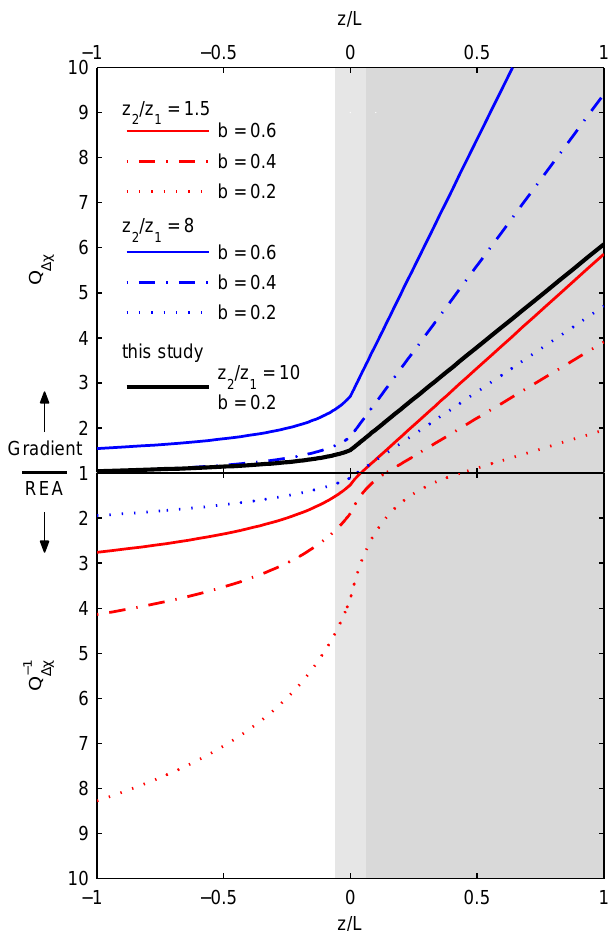
Figure 11. Expected 1χ( Gradient) /1χ (REA) ratio ( Q 1 χ) dis- played on the upper y axis and the 1χ( REA) /1χ (Gradient) ra- ) displayed on the lower y axis (reversed) versus z tio, ( Q − 1 . 1χ L = 8 (blue Shown are the ratios determined with Eq. (11) for m = z 2 z 1 = 1.5 (red lines), representing gradient measure- lines) and m = z 2 z 1 ments above low and high vegetation, respectively, and b values of 0.6 (solid line), 0.4 (dashed line) and 0.2 (dotted line). The black line was calculated with the settings from this study ( m = (z 2 − d)/(z 1 − d) = 10 and b = 0.21). The upper measurement height of the gradient measurement ( z 2 ) was used as a reference height for z in Eq. (11) and in the calculation of the integral turbulence char- L acteristics (Eq. 12). The shaded areas indicate ranges of unstable (white), neutral (light grey) and stable (dark grey) conditions. Dur- ing the latter, fluxes might be prone to large errors when determined with the gradient method, and a turbulence criterion as for the MBR method (Sect. 2.1.2) should be